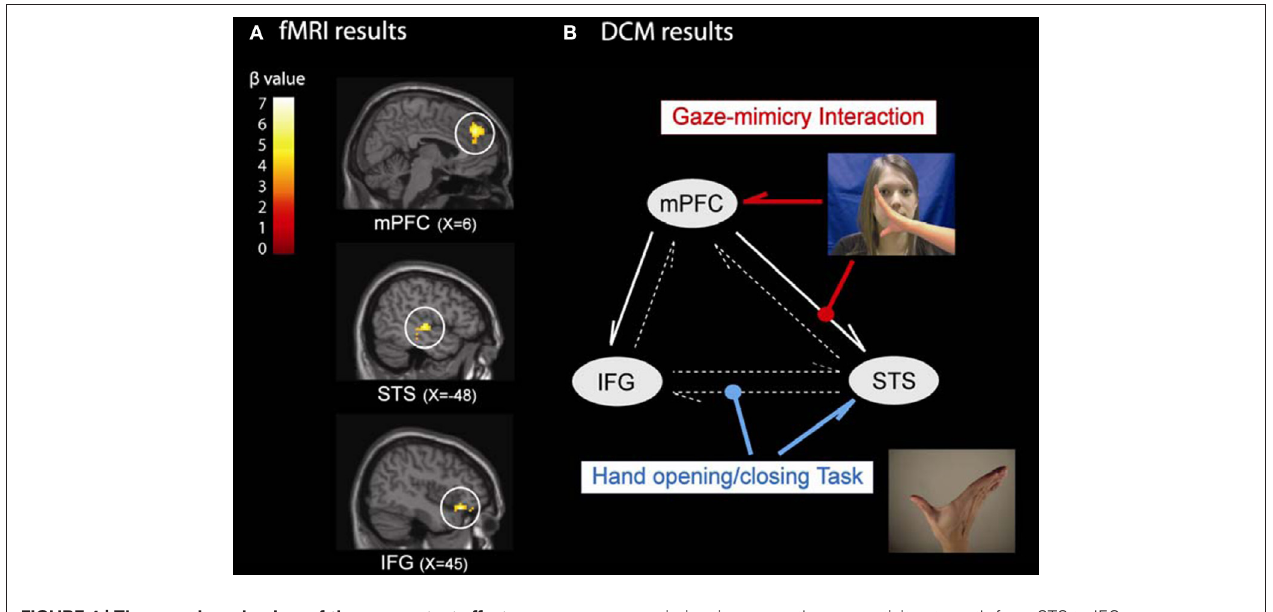
FIGURE 4 | The neural mechanism of the eye contact effect on mimicry. (A) the fMRI results showed three brain regions specifically for the gaze-mimicry interaction: mPFC, STS, and IFG; and (B) the DCM further suggested a best model where the